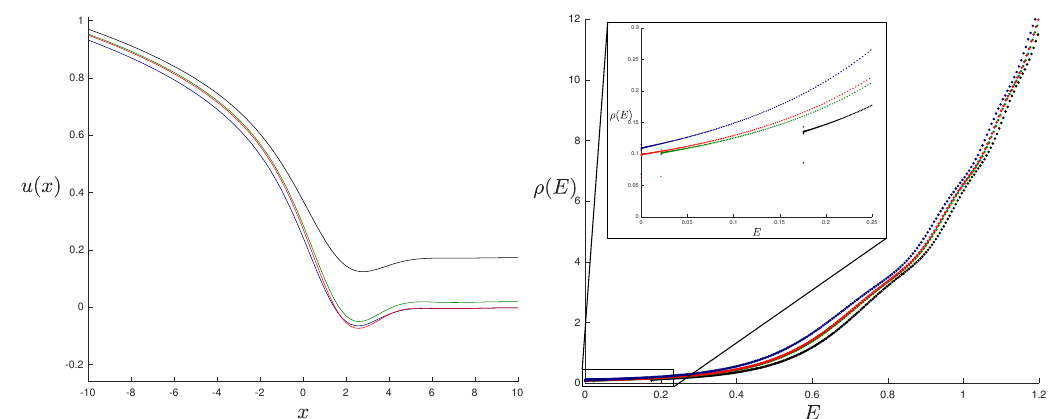
Figure 6. On the left are plots of the non-perturbative potential u ( x ) in the k max = 7 truncation for several λ ≥ 0 and ( α 1 , α 2 ) = (1 / 4 , 1 / 3) . While the blue curve corresponds to pure JT gravity, red and green correspond to λ = 9 λ c / 10 and λ = 11 λ c / 10 respectively, where λ c ’ 1 . 042 (3.15). The black curve is for λ = 2 λ c . On the right (using the corresponding colours) are plotted the full spectral densities obtained from equation (2.6) after computing the spectrum of H [ u ]